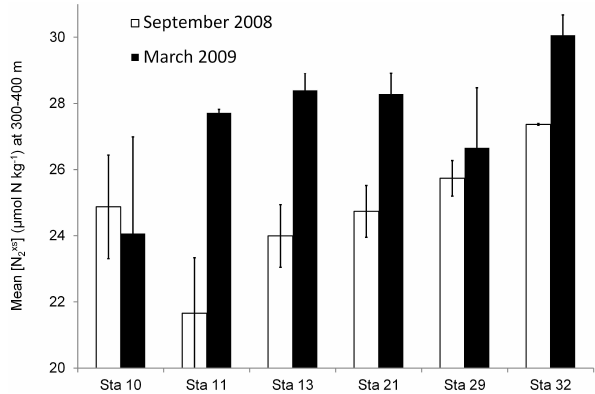
Fig. 6. Mean [N xs ] between 300 and 400m in the Cariaco Basin 2 from all six stations sampled during September 2008 and March